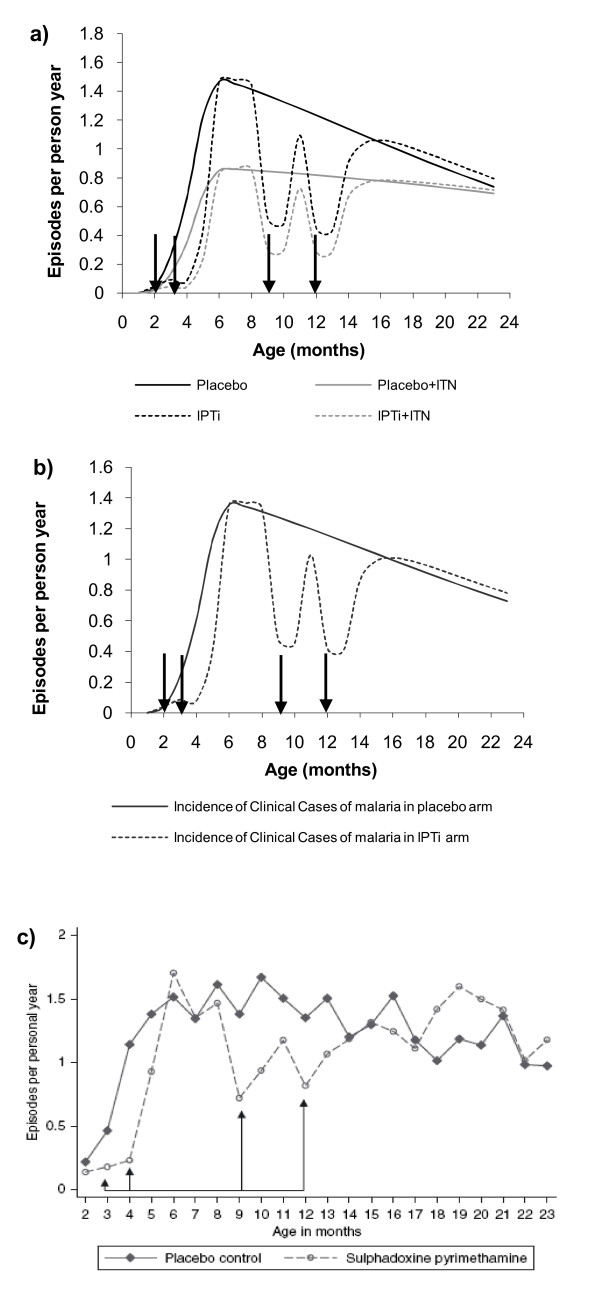
Asymptomatic pool model prediction of monthly clinical cases per child year at risk from the Navrongo, Ghana IPTi study (A) by intervention group and ITN use by age with stable transmission (B) the prediction weighted by ITN coverage and (C) the actual incidence by age in the placebo and IPTi groups from the Navrongo study [18] (by kind permission of Tropical Medicine and International Health, Blackwell Publishing). Arrows indicate time of IPTi dosing.